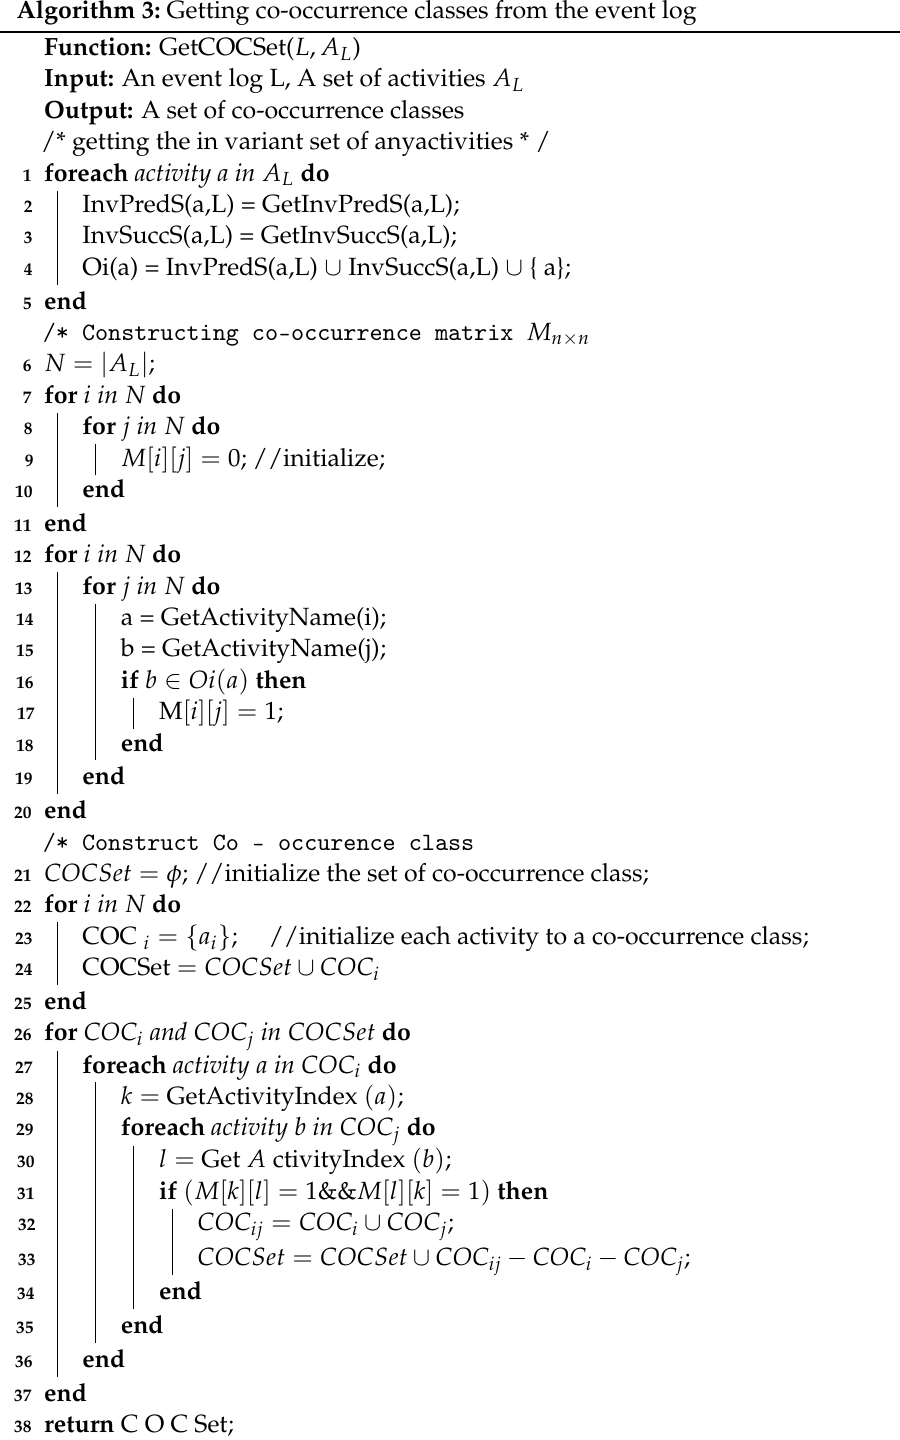
Algorithm 3: Getting co-occurrence classes from the event